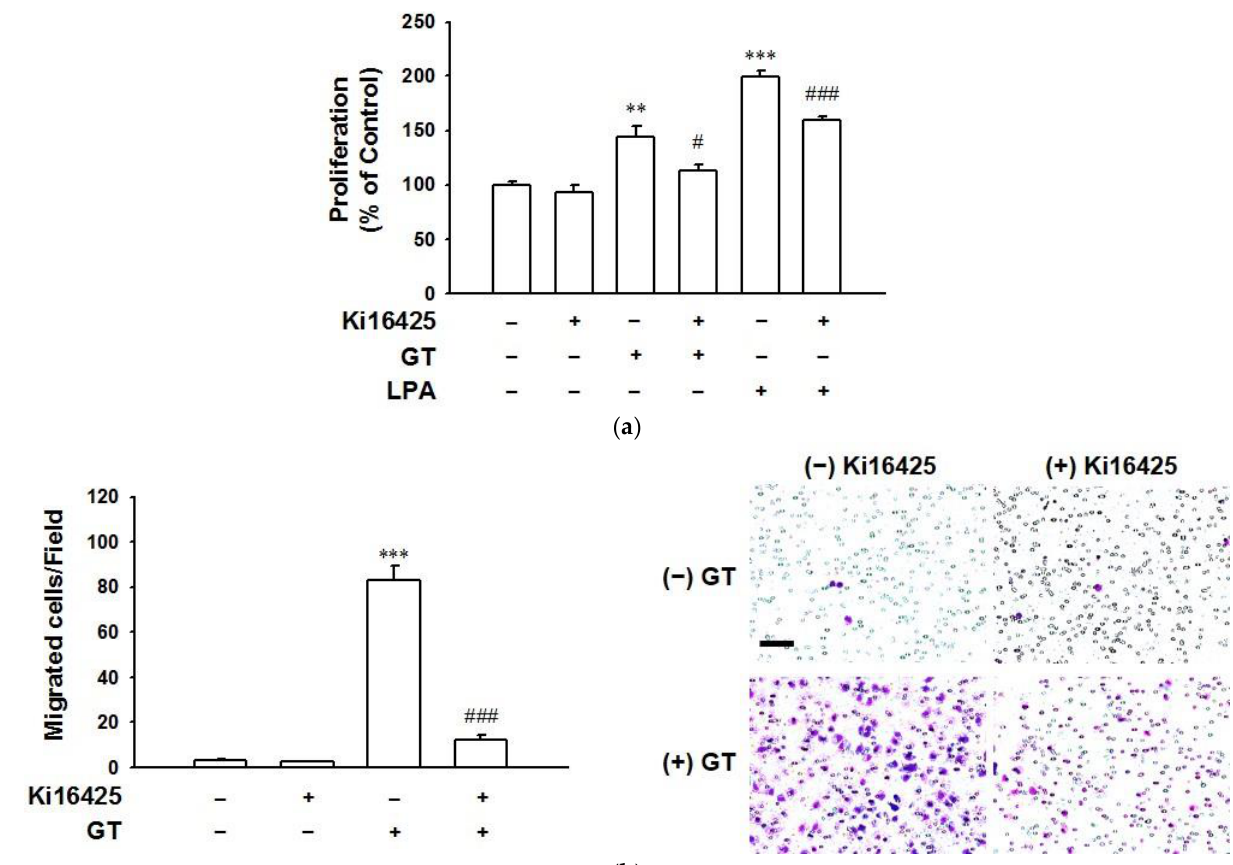
Figure 3. Effect of LPA receptor inhibitor on the proliferation and migration of HaCaT cells. ( a ) Cells were incubated in serum-free medium with gintonin (GT, 10 μg/mL) or lysophosphatidic acid (LPA, 10 μM) in the presence or absence of LPA receptor inhibitor Ki16425 (10 μM) for 24 h. Then , the XTT-based assay was performed. LPA was used as a positive control. Response of untreated cells was considered as 100%. Data are presented as the means ± S.E.M. ( n = 6); ** p < 0.01; *** p < 0.001 vs. untreated cells; # p < 0.05; ### p < 0.001 vs. GT or LPA alone. ( b ) Cells were incubated with serum-free medium containing GT (10 μg/mL) in the presence or absence of LPA receptor inhibitor Ki16425 (10 μM) for 3 h in the modified Boyden chamber . Cell migration was then analyzed as described in the Materials and Methods section. The right panel shows representative images of migrated cells. Scale bar is equivalent to 100 μm. Data are presented as the means ± S.E.M. ( n = 16); *** p < 0.001 vs. untreated cells; ### p < 0.001 vs. GT alone.